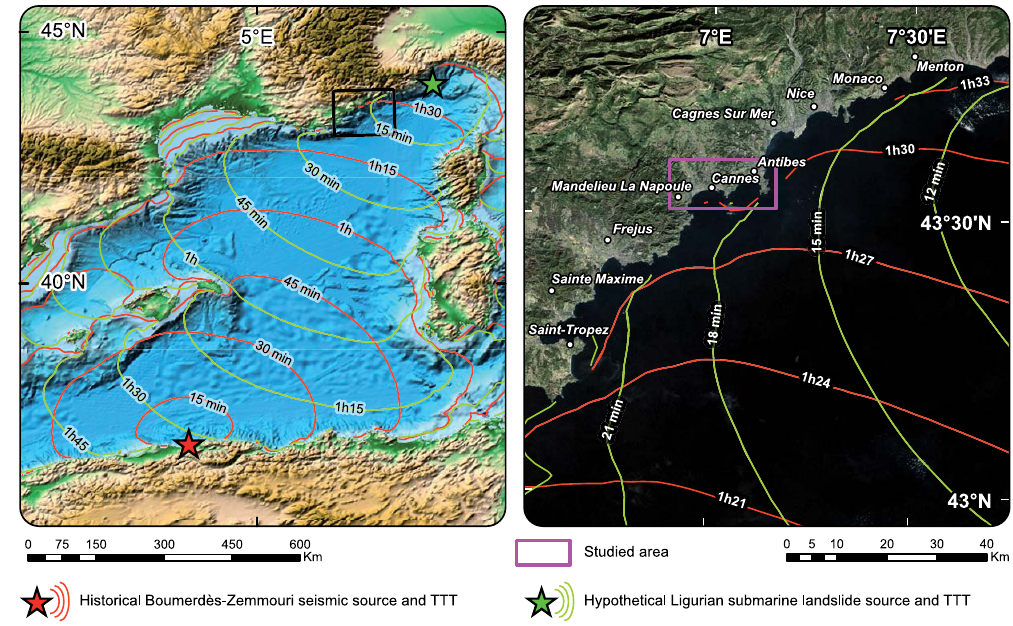
Fig. 1. Tsunami travel times (TTTs) for both hazard scenarios and location of the area studied for evacuation.